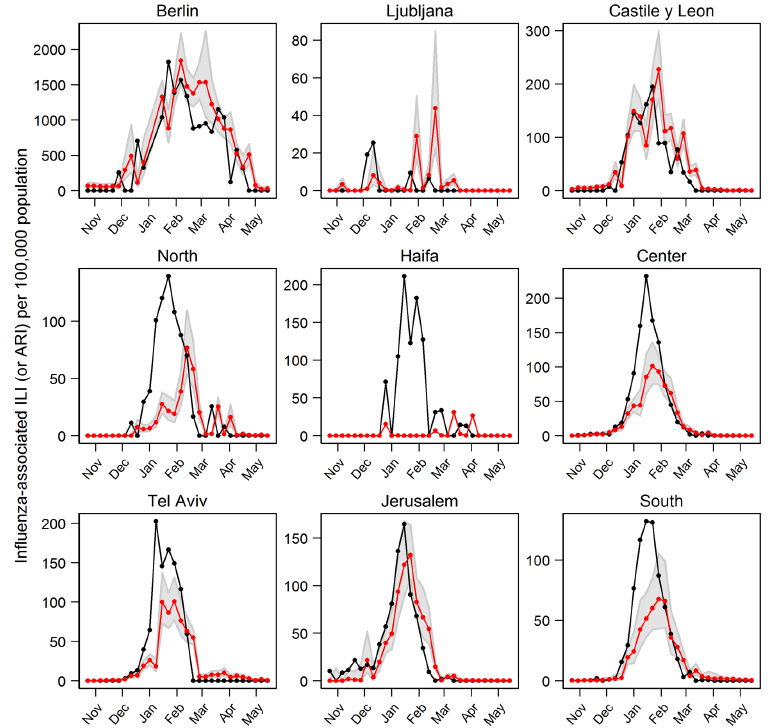
Fig 7. Estimated influenza activity in 2010/2011 season using Model 2 (with minimum temperature). Black line is the observations, red line is the predicted influenza and the shaded areas are the 95% CI. doi:10.1371/journal.pone.0134701.g007 Table 6. Difference in model performance (based on GCV score) between Model 1 and 2. Negative value indicated that the former model had better performance (lower GCV score is preferable). Model 1 is with specific humidity and Model 2 with minimum